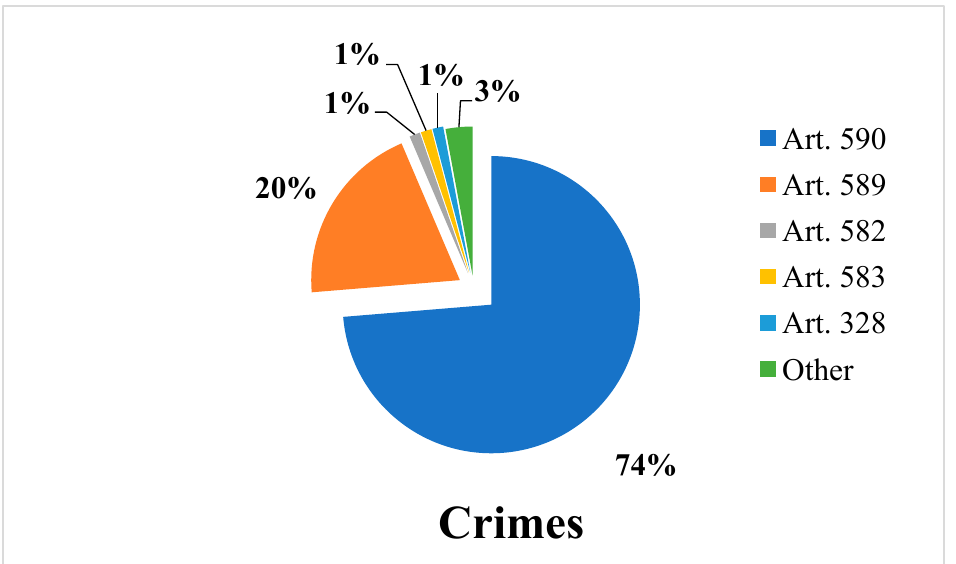
Figure 3. Graph showing the types of crimes prosecuted in the proceedings under study.